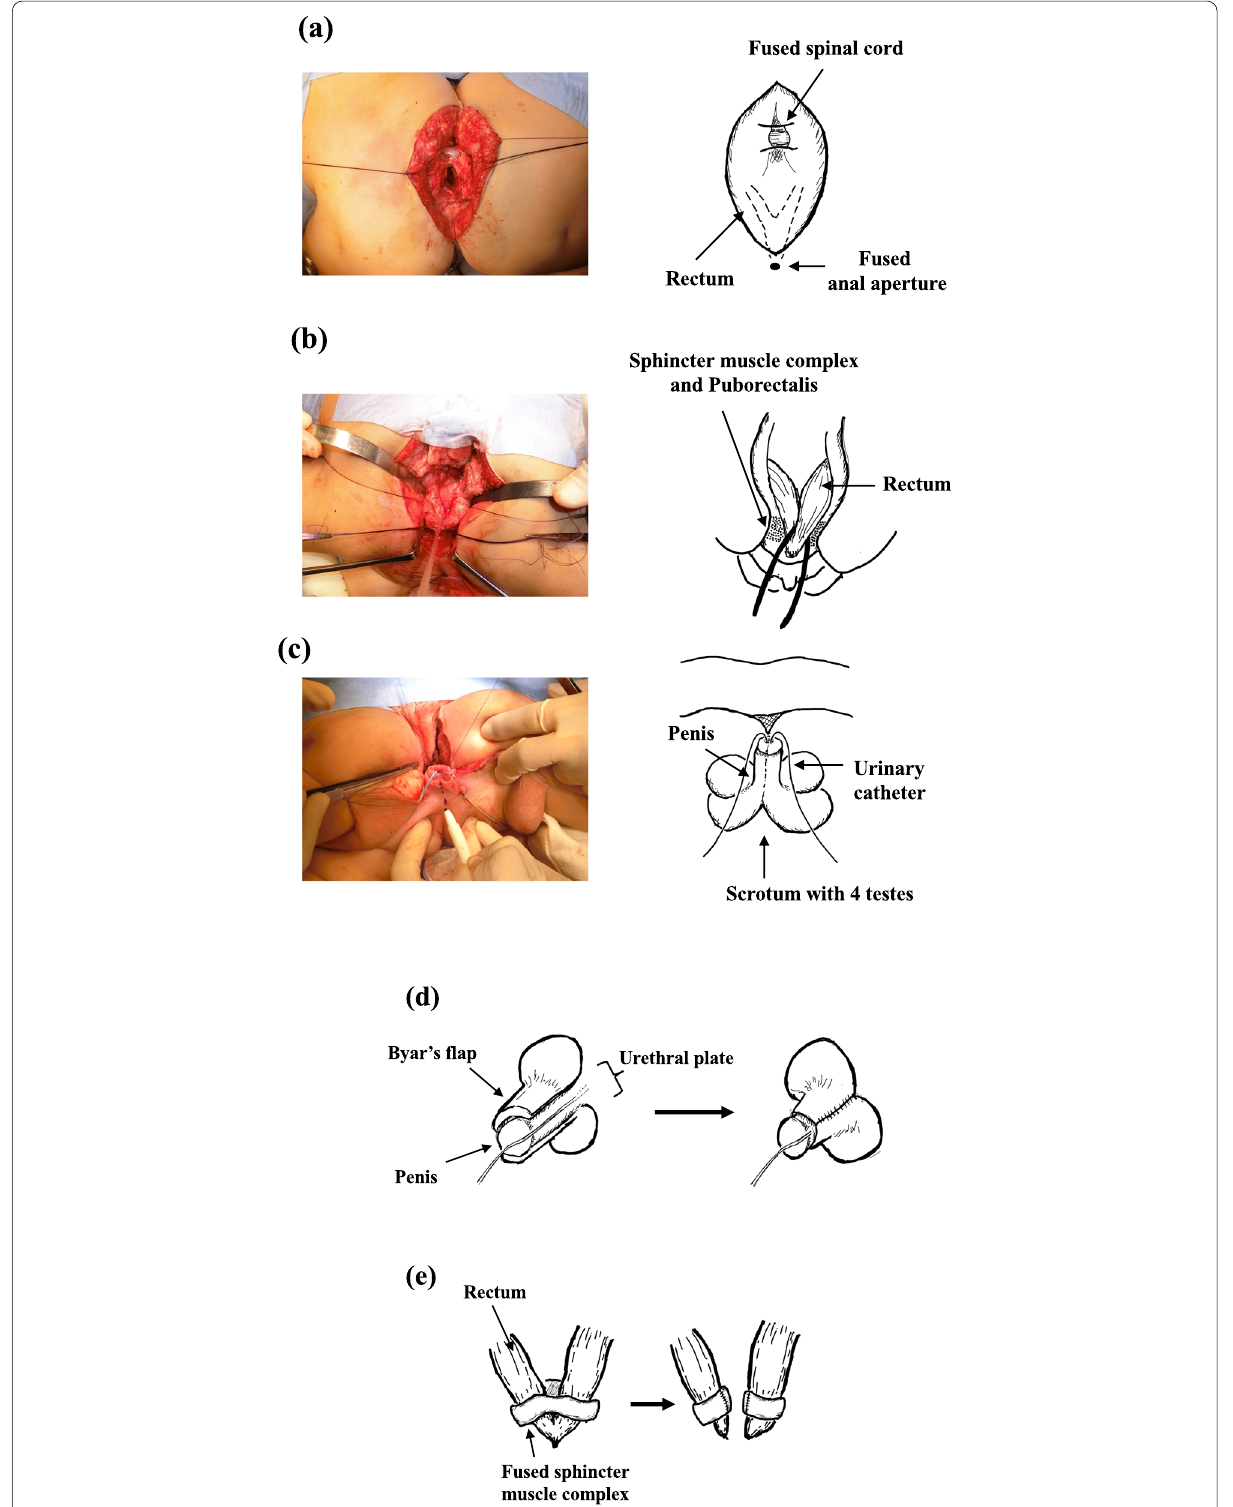
Fig. 3 Separation with anal canal and urethral reconstruction. Operative findings: a fused spinal cord, b fused anus, c fused penis. d The fused penis and urethra were divided into two pairs of bodies, and the urethral plate and penile skin were sutured with Byar’s flap to wrap the penises. e The sphincter muscle complex and puborectalis were fused partially and reconstructed, giving each patient one-half of the sphincter